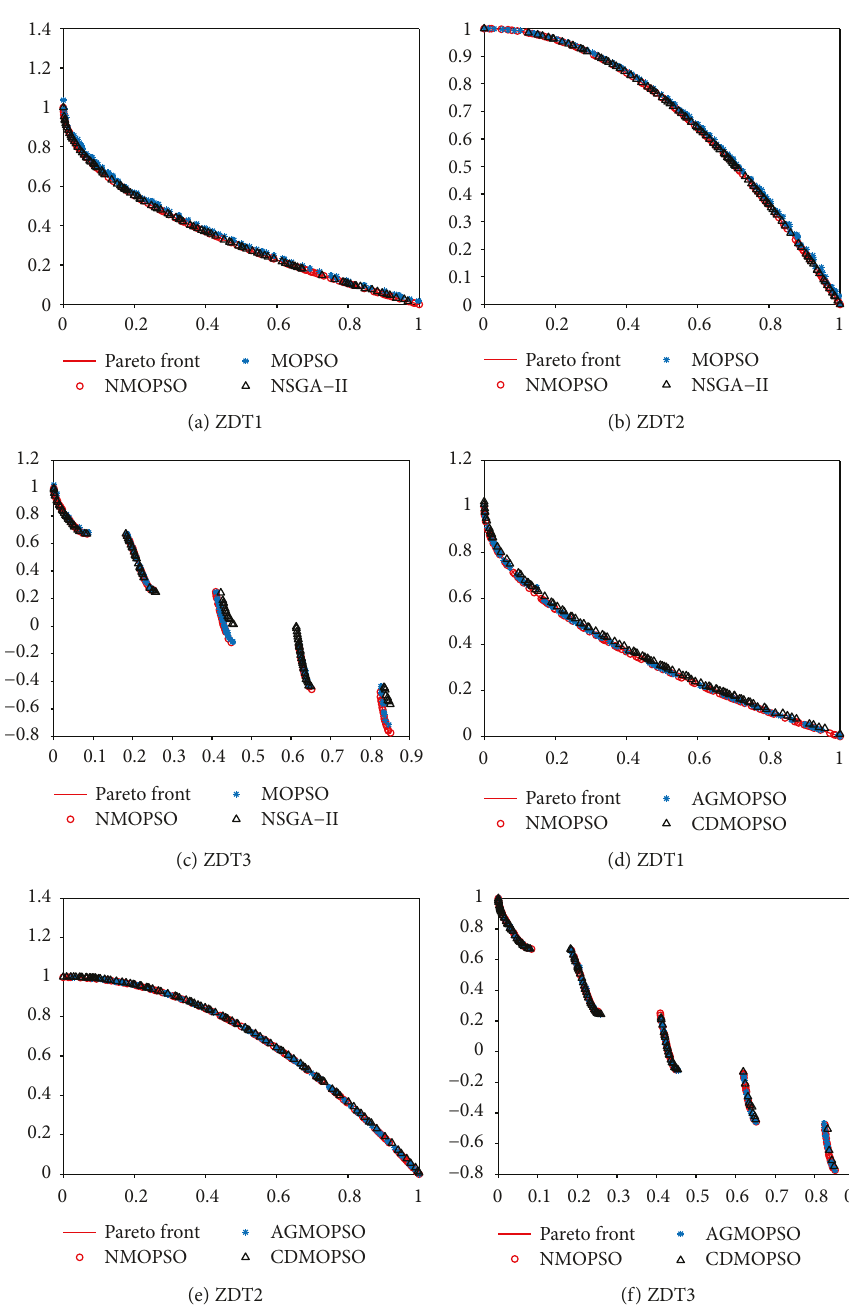
Figure 1: The performance of fi ve